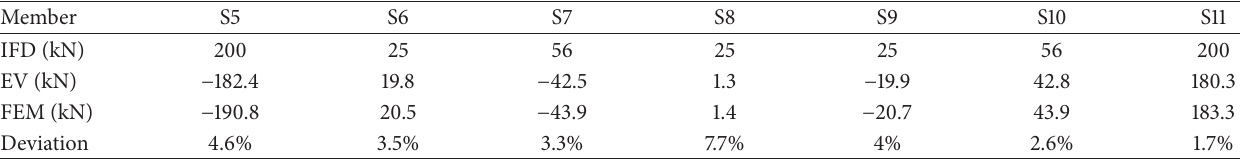
Table 6: Contrast experimental value with the FEM value of composite rods under 600kN ⋅ m.